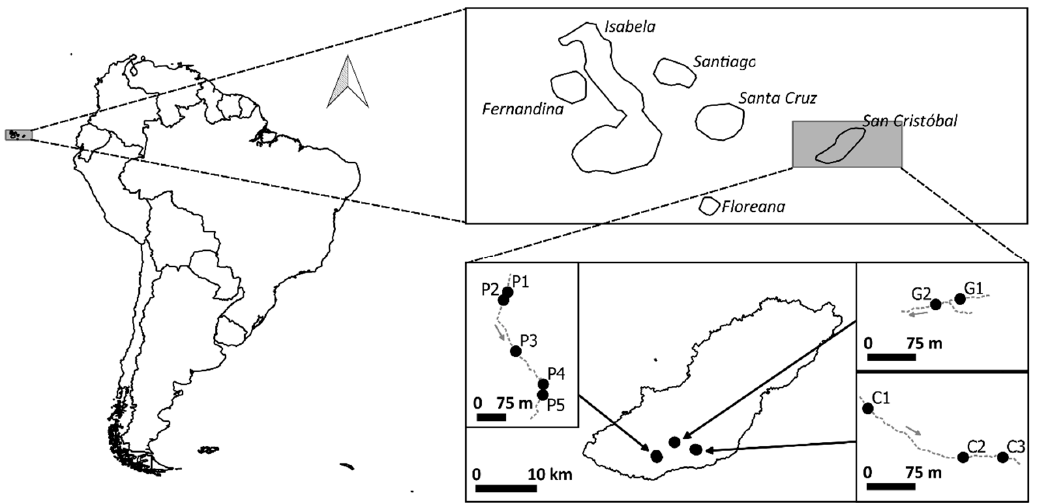
Figure 1. Sampling sites within San Crist ó bal island. Five sites were selected within the Toma de la Polic í a basin (P-sites), three sites in the Chino basin (C-sites), and two sites in the Cerro Gato basin (G-sites). Dotted gray lines depict the observed stream paths, for which the flow direction is indicated with an